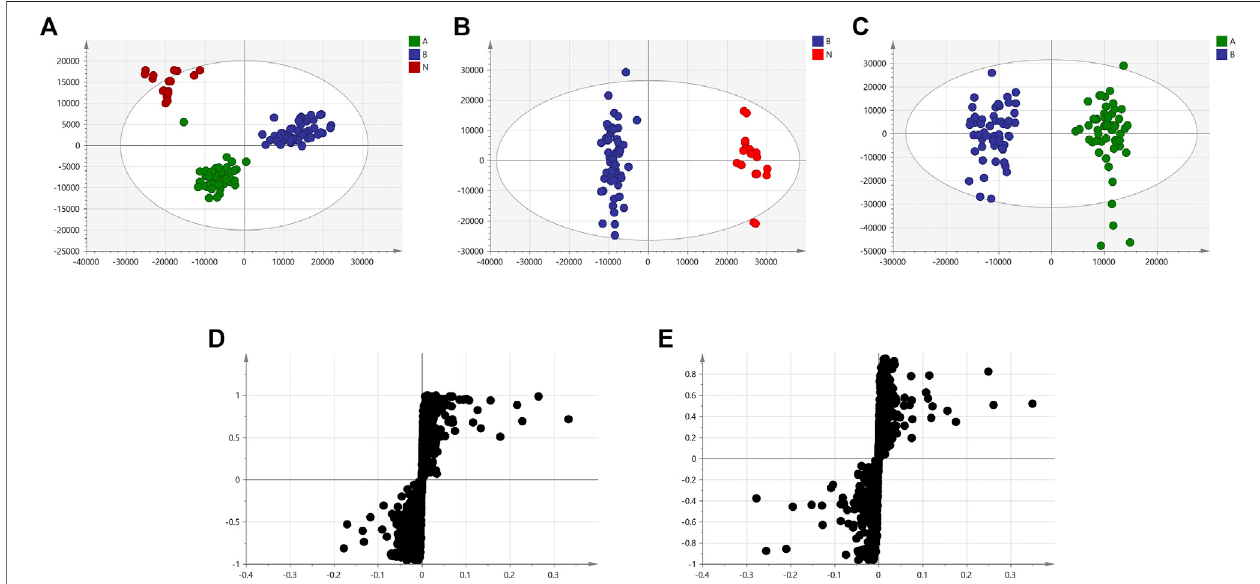
FIGURE 6 | The OPLS-DA score plots and corresponding S-plot loadings plots under positive ion mode. (A) OPLS-DA score plot of the oral disease group, the HLJDD intervention group and the healthy control group (B) Healthy control group and Oral disease group (C) Oral disease group and HLJDD intervention group. Red dot represents the healthy control group, blue dot represents the oral disease group, green dot represents the HLJDD intervention group. (D) S-plot loadings plot of Healthy control group and Oral disease group (E) Oral disease group and HLJDD intervention group.